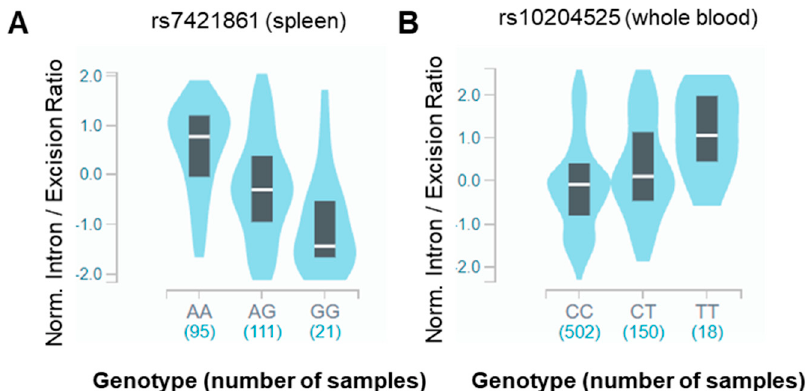
(Figure 2). Using the LINCs as candidate biomarkers of altered splicing in the region of the PDCD1 locus, the data point towards the SNPs altering splicing factor binding sites.